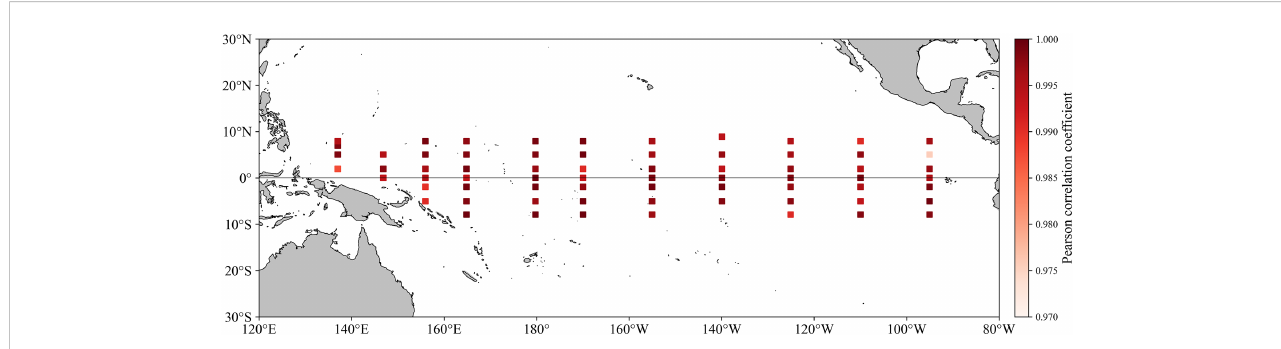
FIGURE 11 Spatial distribution of the temporal Pearson correlation coef fi cient between the ODF-ST sea temperature and TAO observation pro fi les.